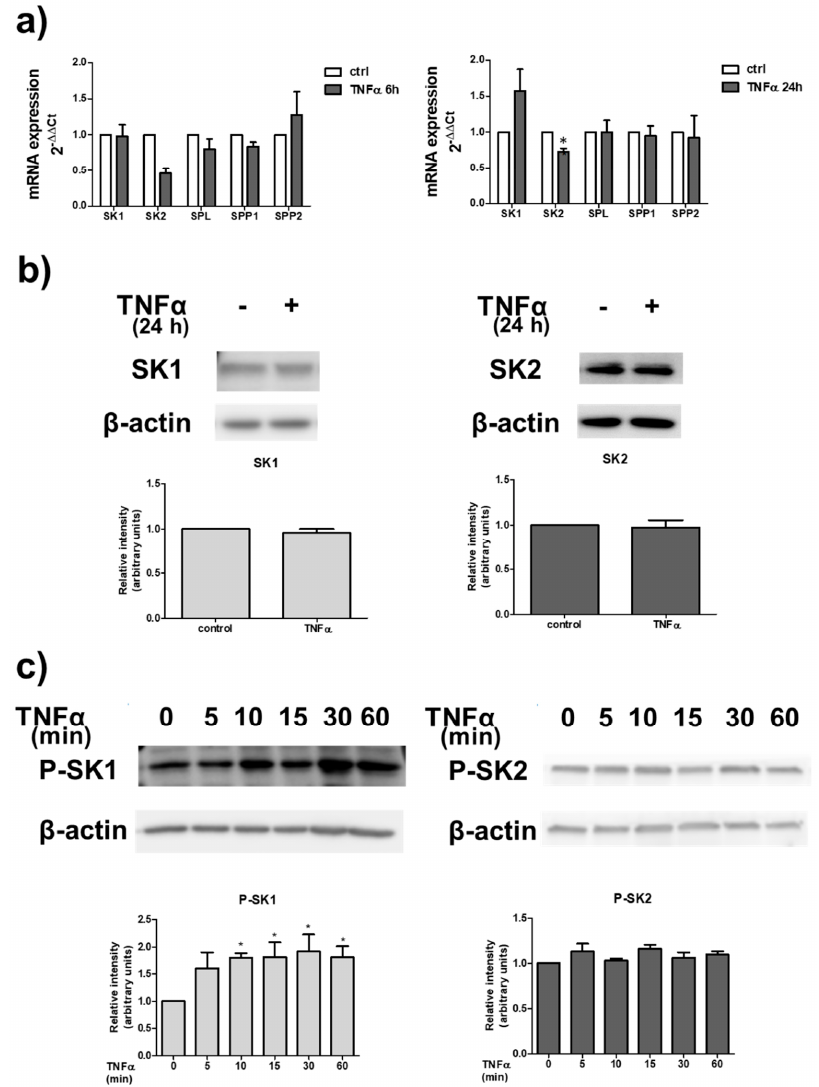
Figure 2. TNF α modulates S1P metabolism. ( a ) Quantitative mRNA analysis was performed by real-time PCR in total RNA extracted from C2C12 myotubes stimulated or not with 100 ng/mL TNF α for the indicated time intervals (6 h and 24 h). mRNA quantitation of S1P metabolism enzymes (SK1, SK2, SPL, SPP1 and SPP2) was based on the 2 − ∆∆ Ct method,